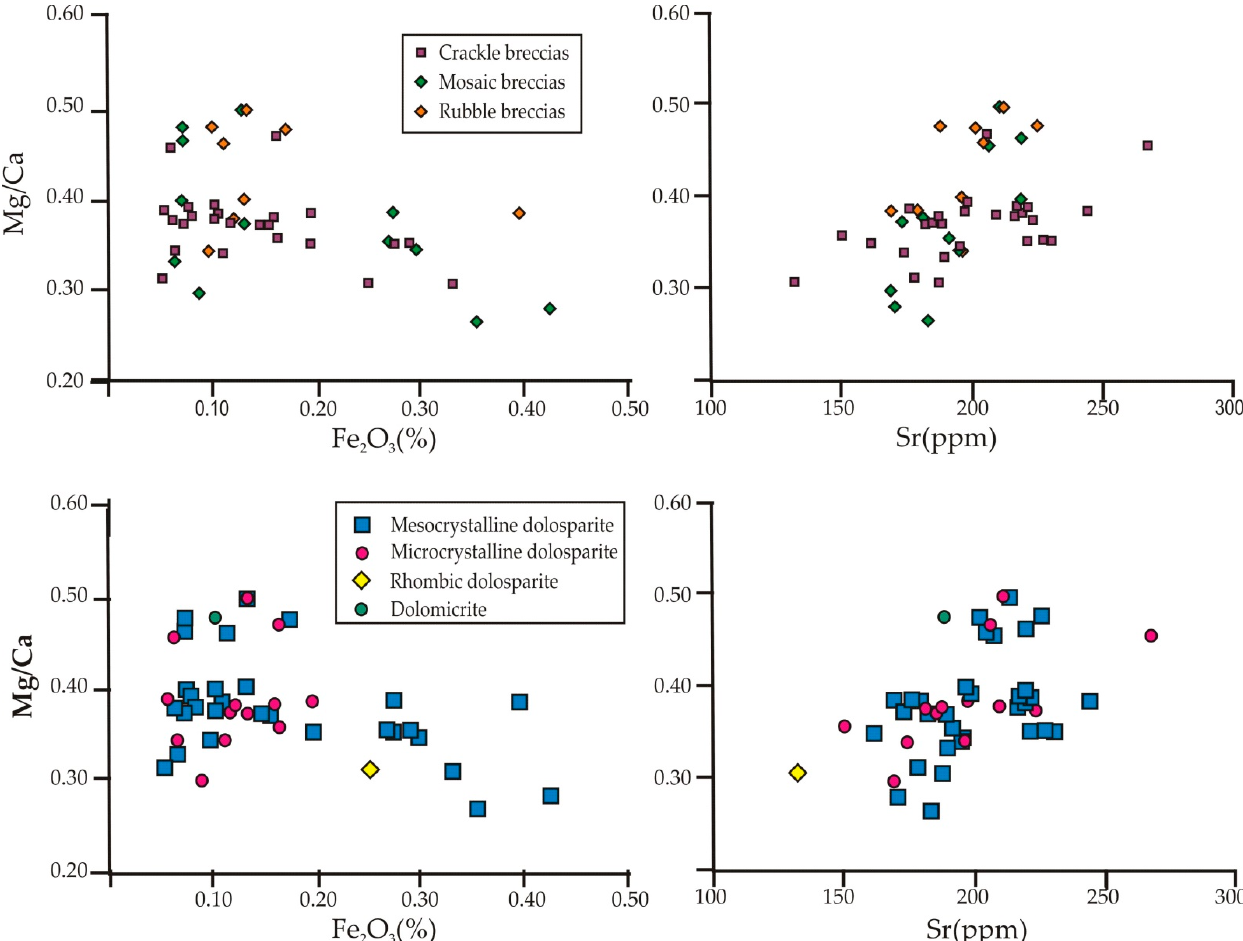
Figure 8. Mg/Ca vs. Fe 2 O 3 and Sr plots from the dolostones of the main breccia microfacies corresponding to all the studied sections.